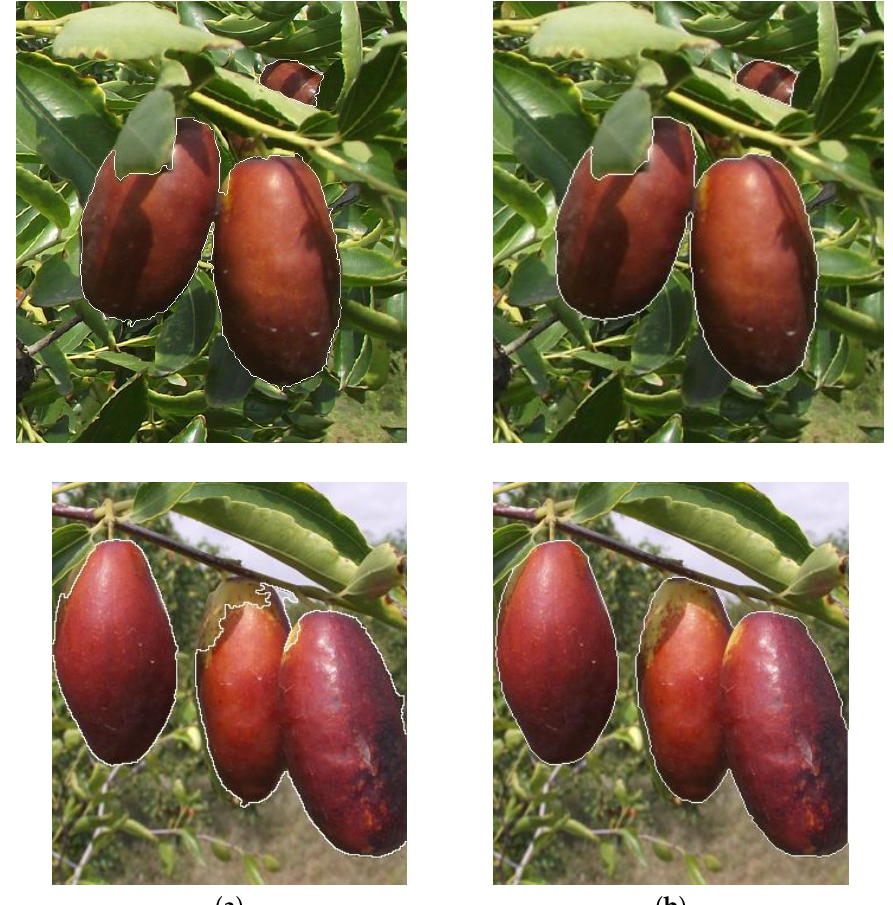
Figure 17. Comparison between artificial segmentation and the proposed algorithm. ( a ) Segmentation of the proposed algorithm. ( b ) Artificial